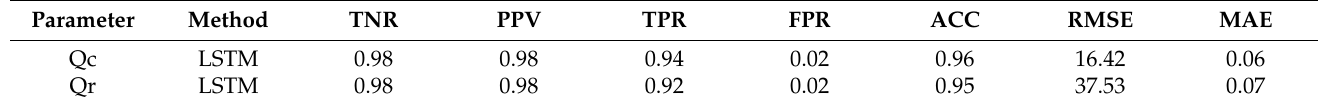
Figure 11. ROC curve and confusion matrix of radiative and conductive heat transfer prediction. Table 2. The learning accuracy and its performance as evaluated by different measurement